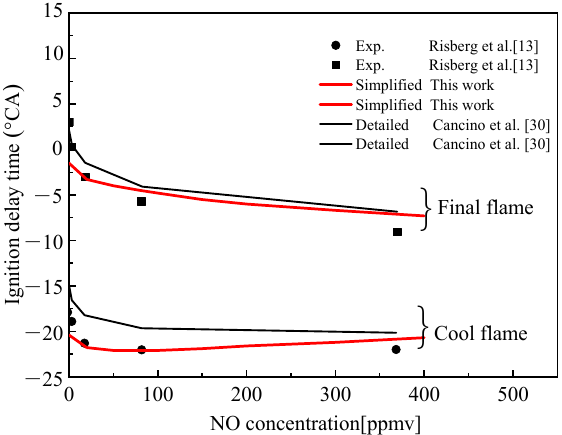
Figure 13. Comparison of simulated and experimental values of the ignition delay time of Surrogate C with the concentration of NO added.